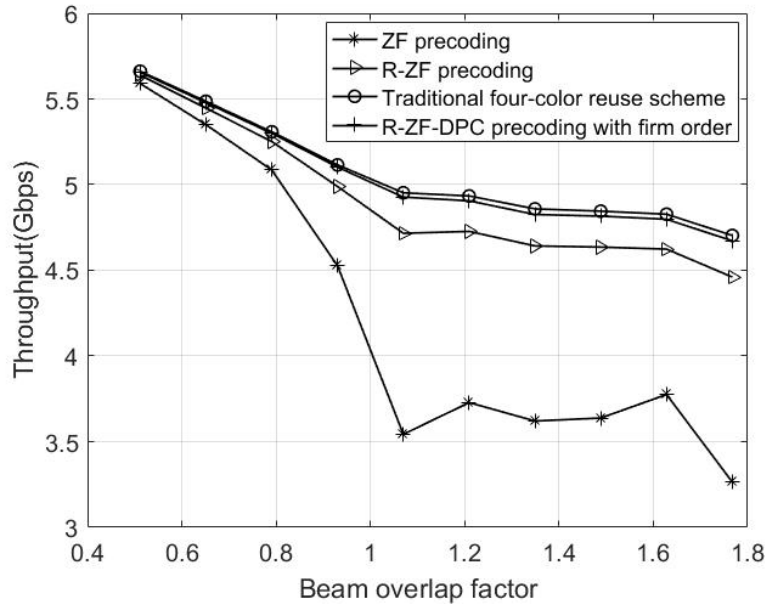
Figure 9. Influence of overlap factor on throughput performance of precoding schemes with users distributed at the edge of the beam.